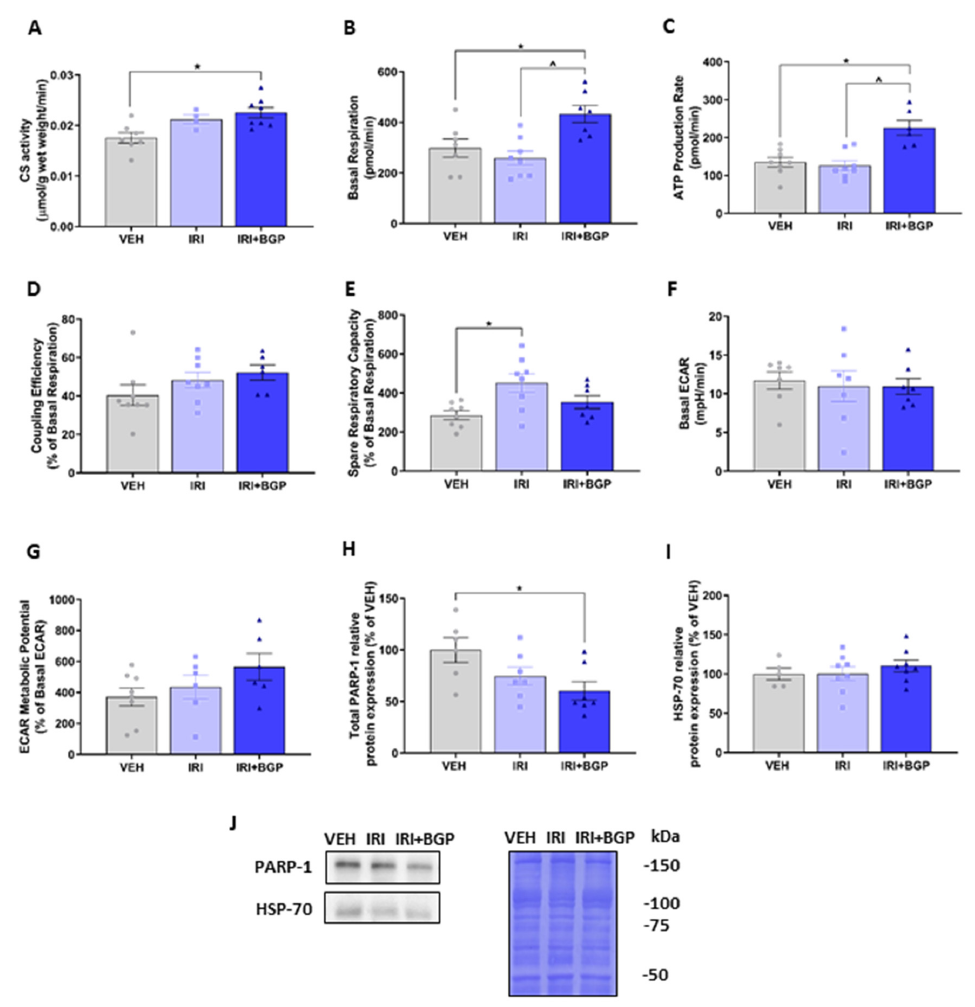
Figure 6. The e ff ect of irinotecan (IRI) and IRI with BGP-15 (IRI + BGP) treatment on skeletal muscle mitochondrial metabolic phenotyping. ( A ) Tibialis anterior (TA) homogenate was analyzed for citrate synthase (CS) activity as a marker of mitochondrial density. Isolated flexor digitorum brevis (FDB) fibers were utilized for mitochondrial metabolic analyses with oxidative respiration indices, i.e., ( B ) basal respiration, ( C ) adenosine triphosphate (ATP) production rate, ( D ) coupling e ffi ciency, ( E ) spare respiratory capacity, as well as glycolytic respiration indices, i.e., ( F ) basal extracellular